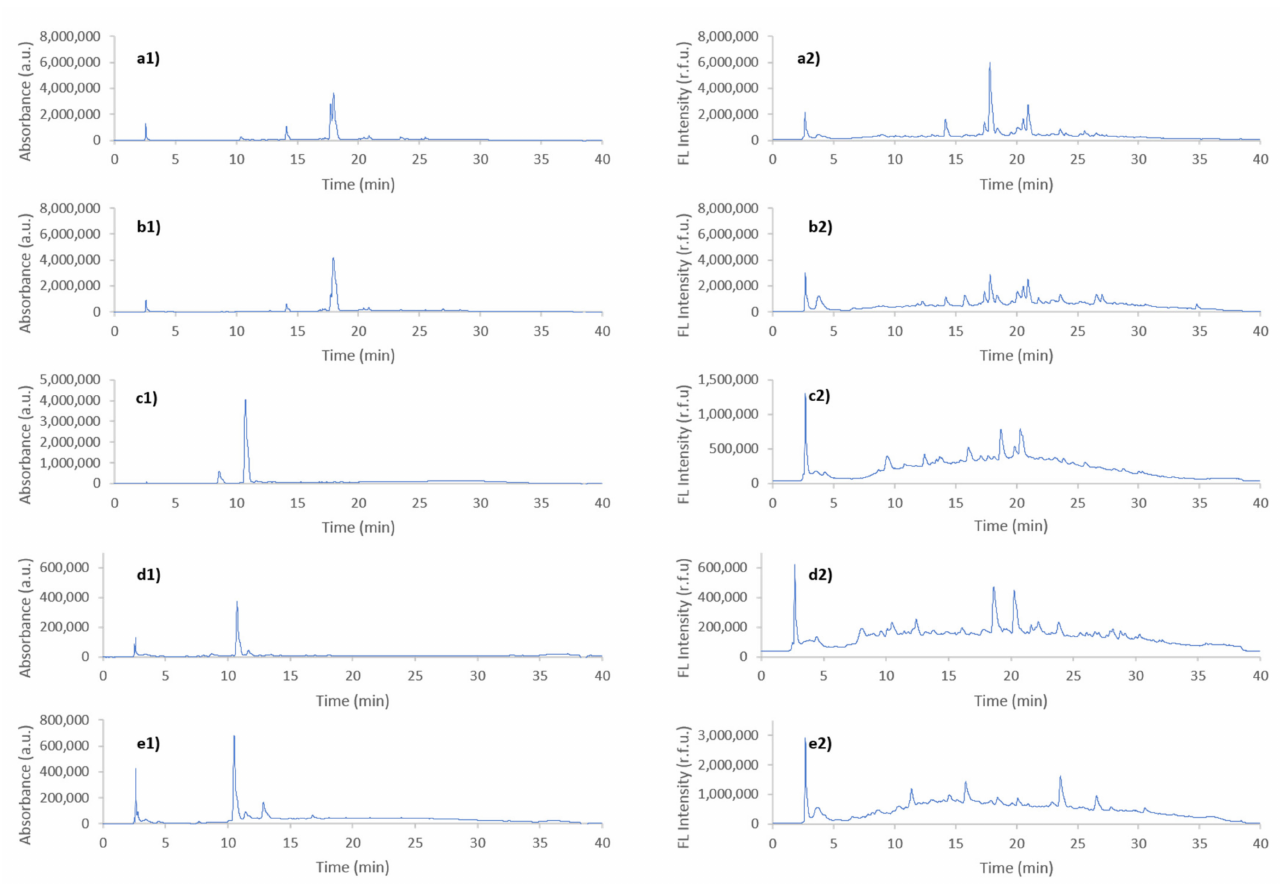
Figure 2. Untargeted HPLC-UV (a1–e1) and HPLC-FLD (a2–e2) fingerprints obtained for a selected sample of ( a ) Vietnamese Arabica coffee, ( b ) Vietnamese Robusta coffee, ( c ) chicory, ( d ) wheat flour, and ( e ) barley. UV detection was registered at 280 nm, and fluorescence detection at 310 nm (excitation) and 410 nm